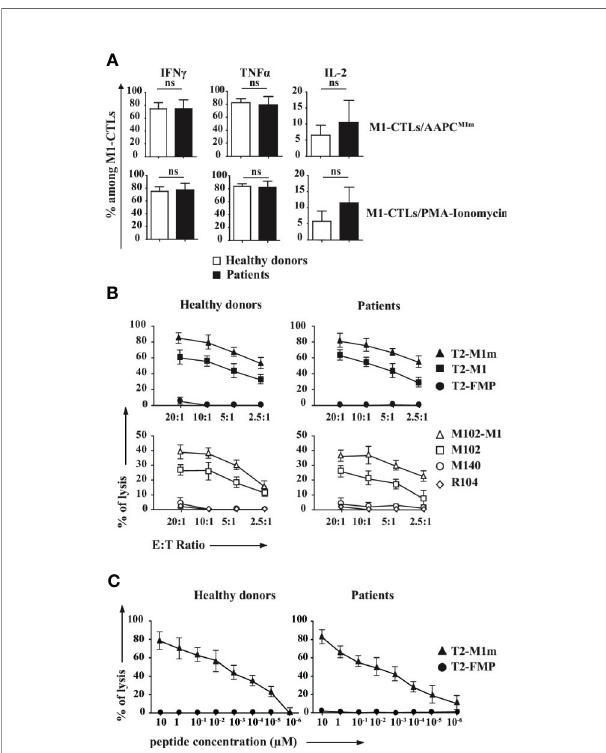
FIGURE 3 | M1-CTLs secrete high levels of cytotoxicity-associated molecules, and display both high cytotoxicity and functional avidity. (A) Expression of IFN g , TNF a and IL-2 in M1-CTLs at D35 was assessed by fl ow cytometry in the presence of either AAPC M1m (upper panels) or PMA (1µg/ml)/ionomycin (10µg/ml, lower panels), both in the presence of brefeldin A (20µg/ml) for 4h. Histograms were obtained from ten healthy donors (white bars) and six patients (black bars) and shown with standard errors of means. Statistical tests ( t tests) were performed to compare both groups. Not signi fi cant (ns): p > 0.05. (B) M1-CTL cytotoxic speci fi c activity was assessed in standard 4-hour 51 Cr release assays. Target cells were T2 cells (upper graphs) pulsed with MART-1 A27L analogue peptide (M1m, squares), MART-1 native peptide (M1, triangles), or Flu Matrix Protein-derived control peptide (FMP, circles) at a peptide concentration of 10µM. Melanoma cell lines (lower graphs) HLA- A*0201 + MART-1 + (M102, open squares), transfected to overexpress MART-1 (M102-M1, open triangles) were also used as target cells. HLA-A*0201 - MART- 1 + (M140, open circles) and HLA-A*0201 + MART-1 - (R104, open diamonds) cells were used as controls. Ratios of effector cells (E) per target cells (T) 20 to 1, 10 to 1, 5 to 1 and 2.5 to 1 were used in our experiments. (C) M1-CTL avidity assay was performed using T2 cells pulsed with various concentrations (from 10 to 10 -6 µM) of MART-1 A27L analogue peptide (M1m) as target cells. FMP was used as a control for non-speci fi c lysis. (B, C) Graphs represent the results obtained with ten healthy donors (left graphs) and six patients (right graphs), each donor having been studied in three independent experiments. Data are represented with standard errors of